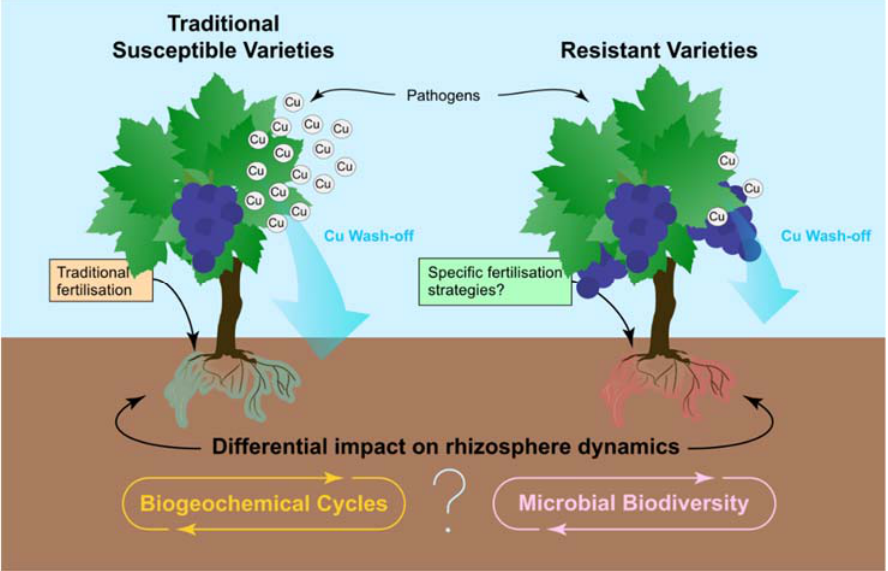
Figure 4. Traditional susceptible varieties vs. resistant varieties in viticulture. The protection of traditional susceptible varieties from pathogen infections requires the repeated application of Cu-based fungicides, which, through drift phenomena and rain wash-offs, can cause a consistent accumulation of Cu in vineyard soils. The increased Cu concentration in soil can, on one hand, induce vine plants to modify their exudation to cope with Cu toxicity, and, on the other hand, promote an alteration of soil microbial biodiversity. The combination of modified exudation patterns with an altered rhizosphere microbial community might impact the biogeochemical cycles of mineral nutrients, thus modifying their availability to plants. In resistant varieties, the protection against pathogens requires lower application rates of agrochemicals, thus also reducing the input of Cu. Nonetheless, the expression of the resistance gene(s) might alter the physiology of vine plants at transcriptomic, proteomic and metabolomic levels, in this case also causing a modification in the exudation pattern. In addition, evidence shows that resistant varieties might require specific fertilization strategies in order to fully present the resistance traits. Again, an altered exudation pattern combined with the input, albeit minimal of Cu and fertilizers may impact the rhizosphere dynamics, affecting both soil microbial biodiversity and the biogeochemical cycles of mineral